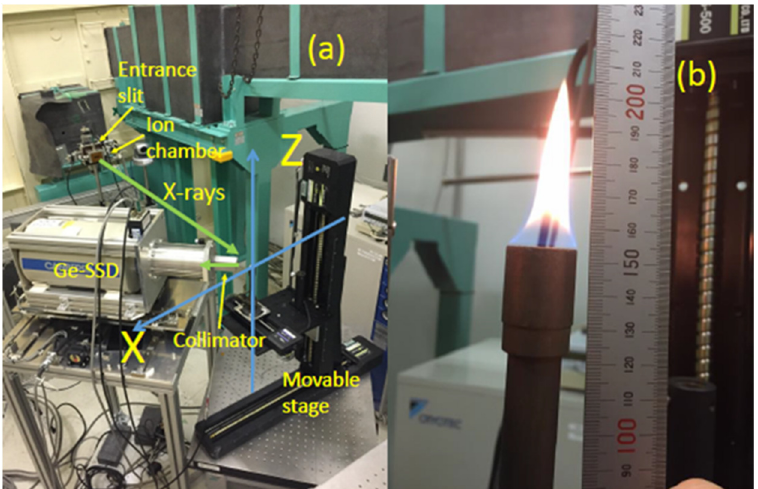
Figure 1. ( a ) Photograph of experimental setup of the present experiment. ( b ) Photograph of the present laminar diffusion